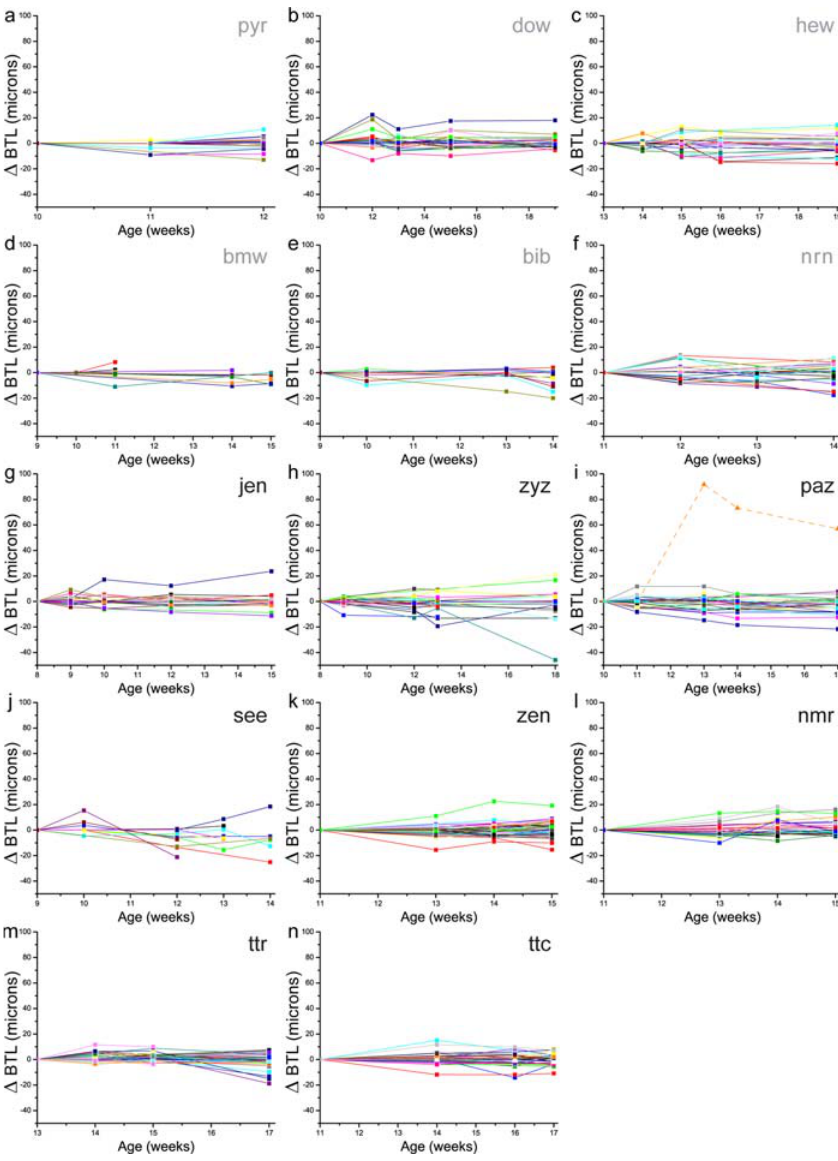
Figure 7. The Change in BTL is Plotted for Each Individual Monitored Branch Tip of Every Imaged Cell Three-letter code, top right. (A–F) pyramidal cells; (G–N) non-pyramidal cells. Triangles and dashed lines denote the minimum length of the branch tip as it exceeds the border of the imaging